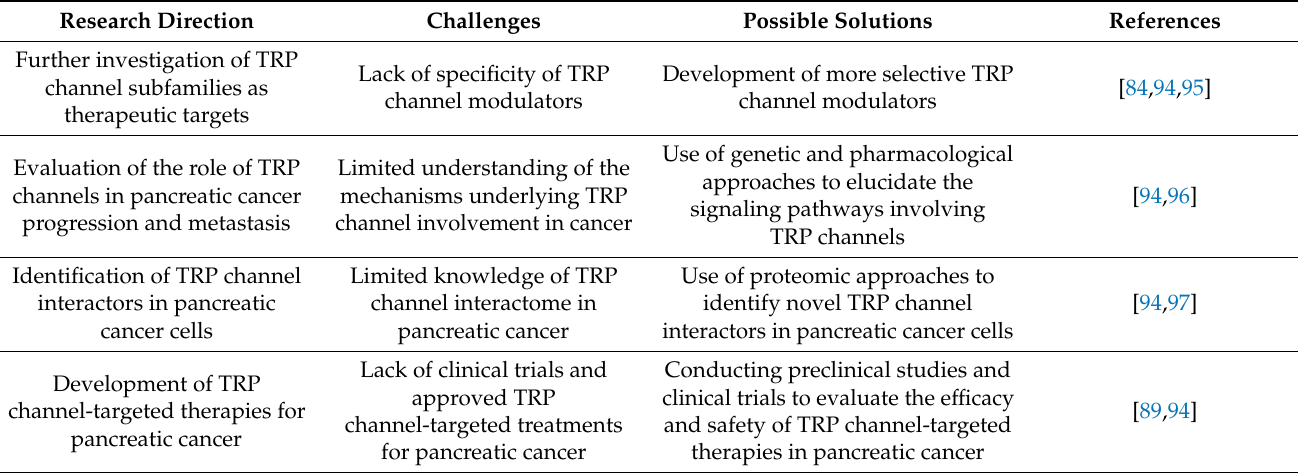
Table 2. Summary of the future research direction of TRP channels interactome as a potential therapeutic target in pancreatic ductal adenocarcinoma, the challenges, and possible